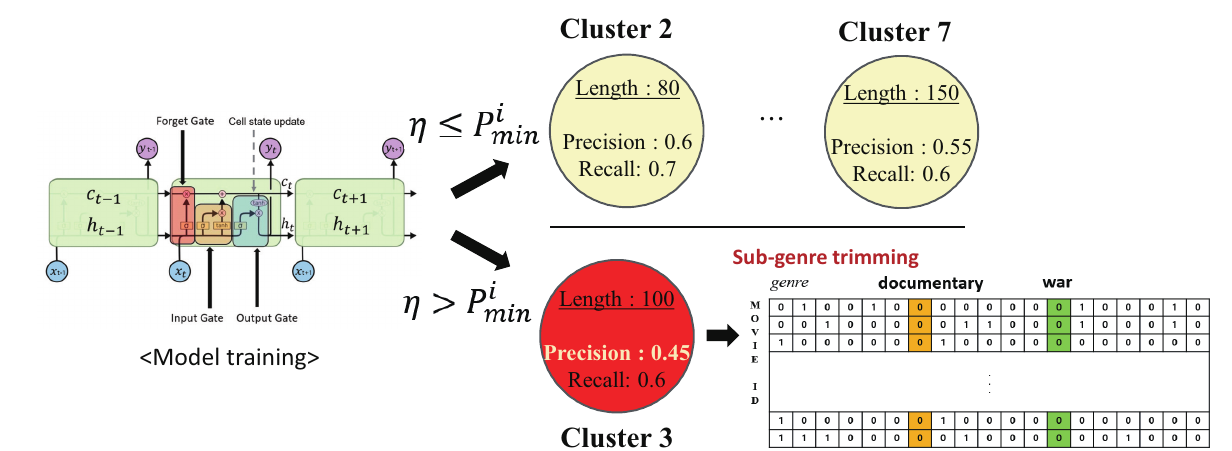
Figure 10. Subgenre trimming. In this example, we set η =0.5 and there are two types of performance metrics: precision and recall. We see that the minimum value of evaluation metrics P 2 respectively. Hence, these clusters are not regarded as the trimming clusters. However, P 3 which is regarded as a trimming